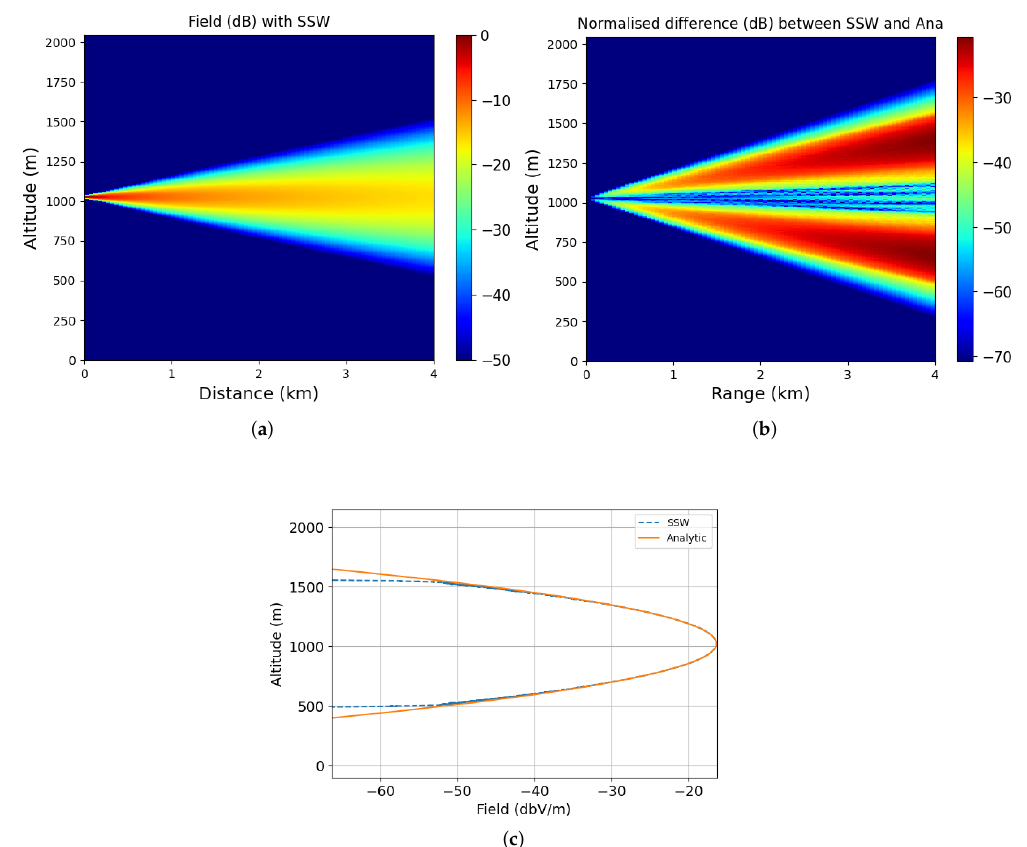
Figure 3. Propagation in free space for comparison with the exact analytical solution of the CSP. ( a ) Normalized field obtained with SSW. ( b ) Normalized difference between SSW and the analytical solution. ( c ) Comparison of the exact solution and of the field obtained with SSW at the last iteration. ( a ) Normalized reduced field u (dB) obtained with SSW. ( b ) Normalized difference between SSW and the exact solution. ( c ) Exact solution and field obtained with SSW at the last